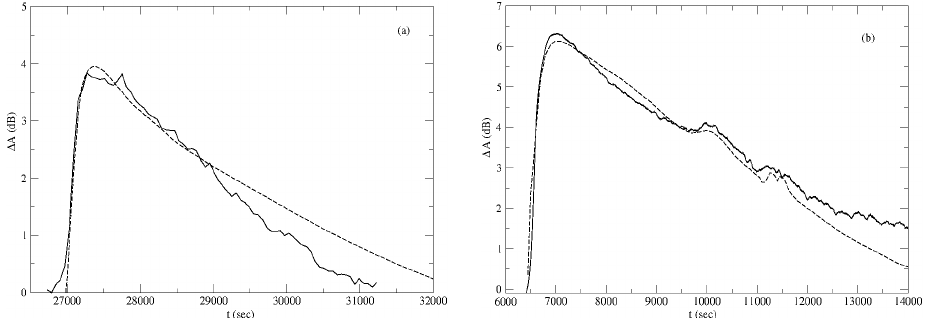
Fig. 9. Simulation results of VLF amplitude modulations (dotted line) and corresponding observed VLF data (solid line) are plotted with UT for an (a) M-class flare and an (b) X-class flare, respectively.